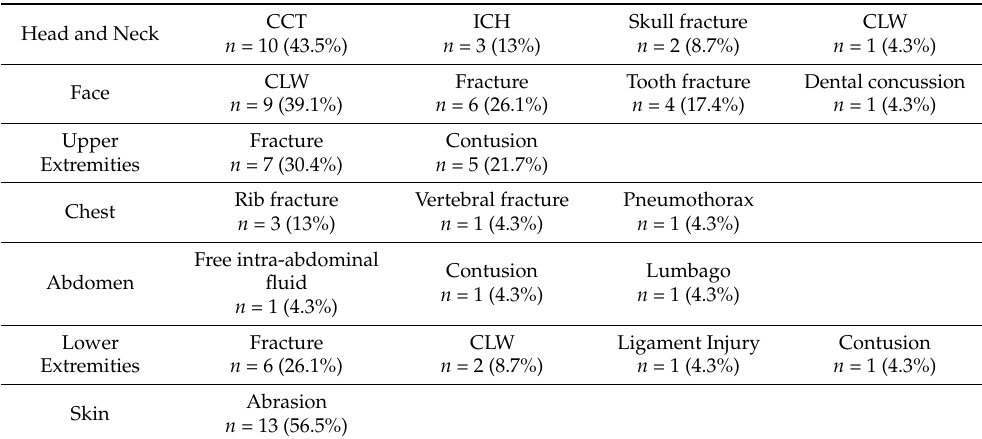
Table 2. Number and type of injuries for each body region in relation to total patient amount ( n = 23). Head and Neck